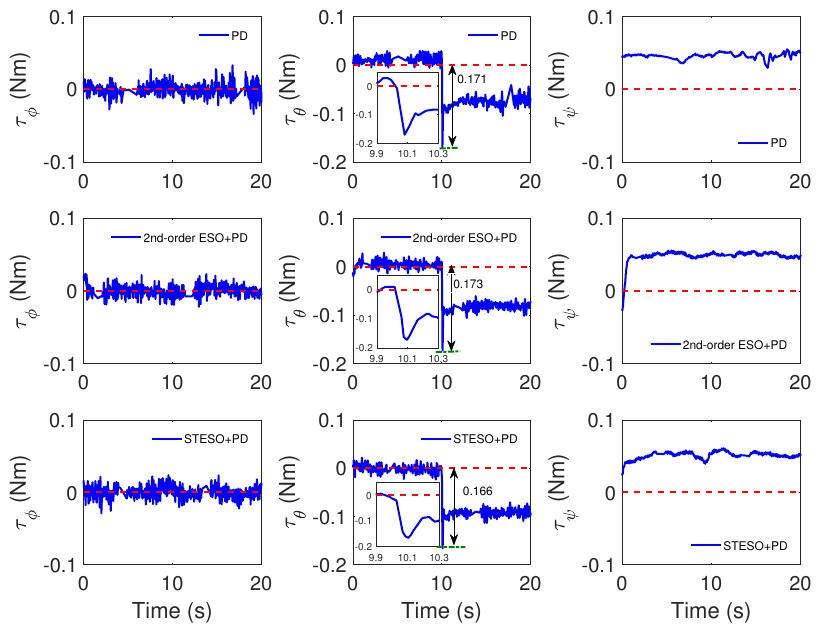
Figure 12. Control input during flight experiments in Case A.